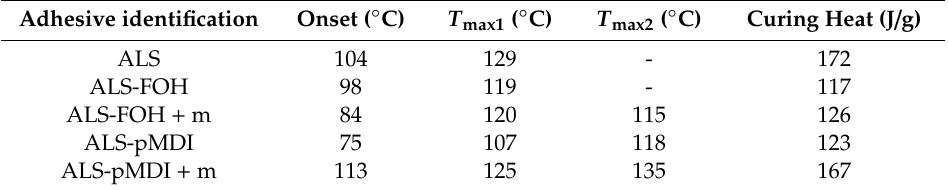
Table 2. Details on the DSC thermograms of adhesive systems based on ammonium lignosulfonate (ALS), furfuryl alcohol (FOH), and pMDI as crosslinkers, and with or without mimosa tannin (m). Adhesive identification